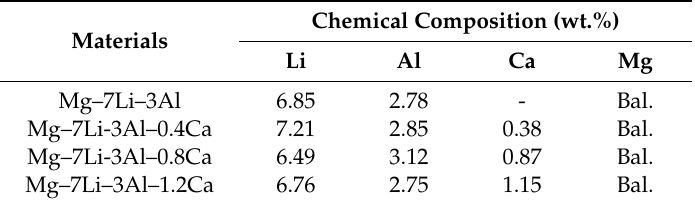
Table 1. Chemical composition of the extruded